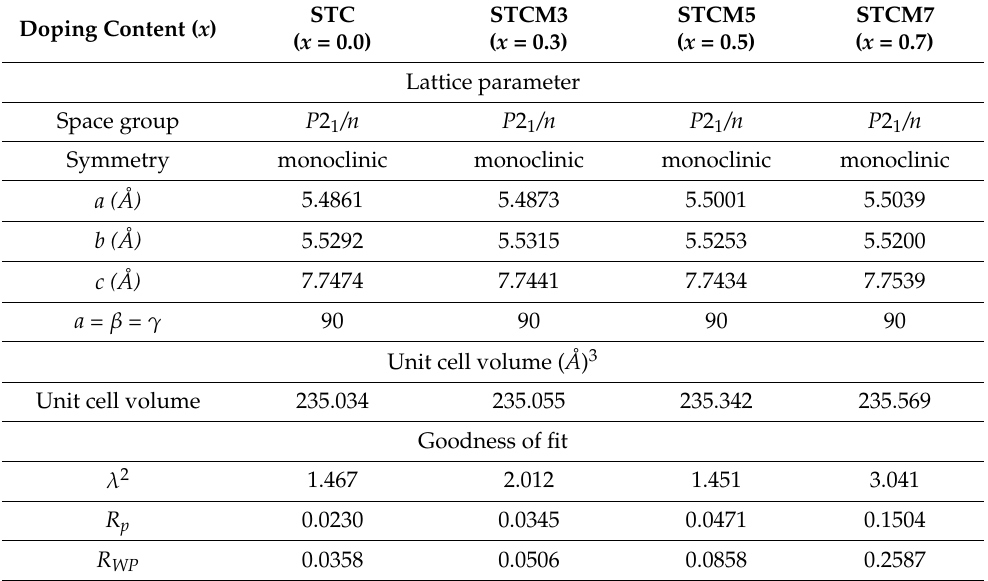
Table 1. Crystallographic parameters of the STC and STCM samples (where 0.0 < x < 0.7) from the Rietveld refinements of the XRD data